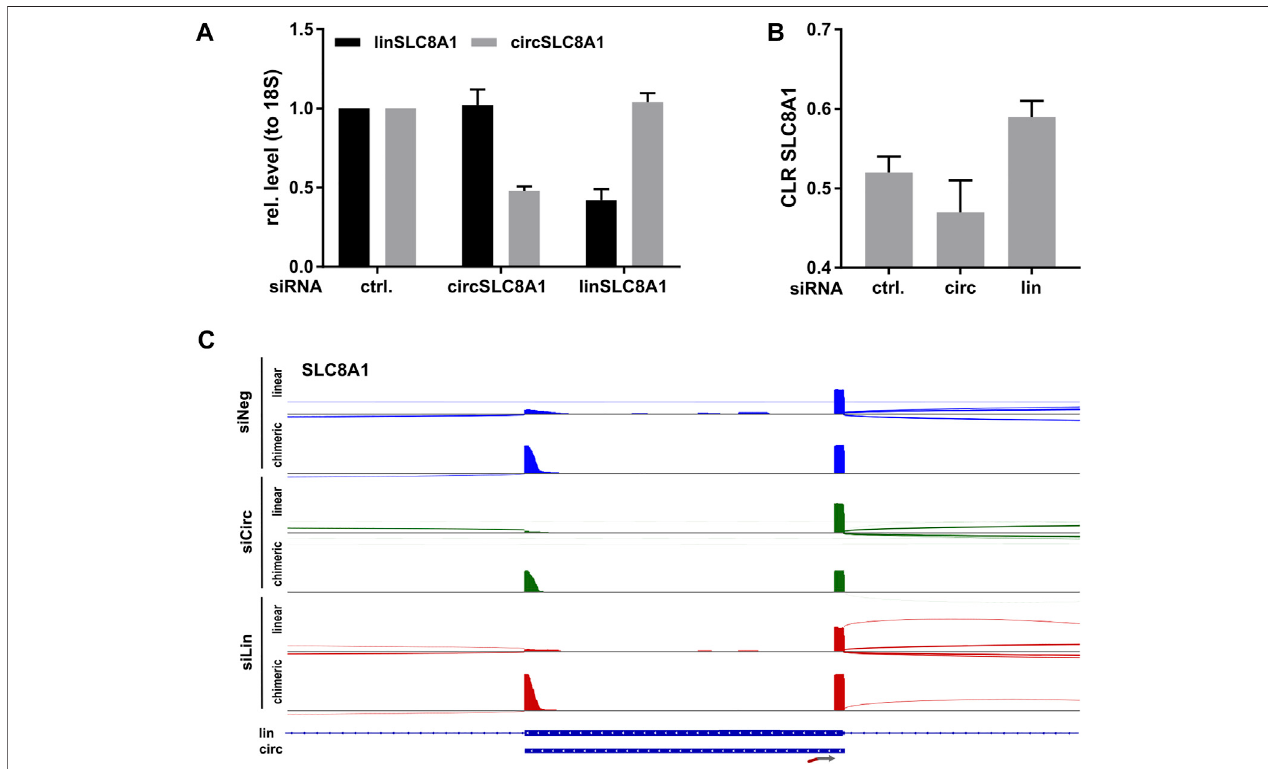
FIGURE 3 | Lexo-circSeq analysis of SLC8A1-depleted hiPSC-CM. hiPSC-CM was transfected with siRNAs targeting circSLC8A1, linSLC8A1 or a non-targeting siRNA (ctrl.) as control. Cells were analyzed 48 h post transfection (A) RT-qPCR analysis of linSLC8A1 and circSLC8A1. Data were normalized to 18S and the mean of thecontrolsamples.n=2. (B) CLRforSLC8A1fromLexo-circSeqanalysisasindicated.n=2. (C) SashimiplotofthetargetedregioninSLC8A1.Linearreadsareshown in the respective upper panels, chimeric reads in the lower panel. The different experimental conditions are indicated by color. The exon structure of the SLC8A1 mRNA and coordinates of the conserved circRNA are depicted below. All panels were scaled to a data range of 0-404 reads. The binding site of the FSS primer is indicated by an